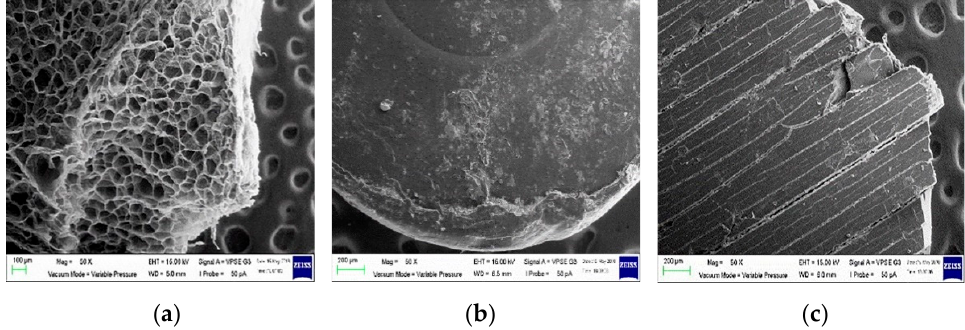
Figure 6. Surface features of sampled microplastics through SEM. ( a ) Structure of a polystyrene, ( b ) polyethylene bead, and ( c ) cracked surface of polypropylene fragment. ( b ) polyethylene bead, and ( c ) cracked surface of polypropylene fragment.